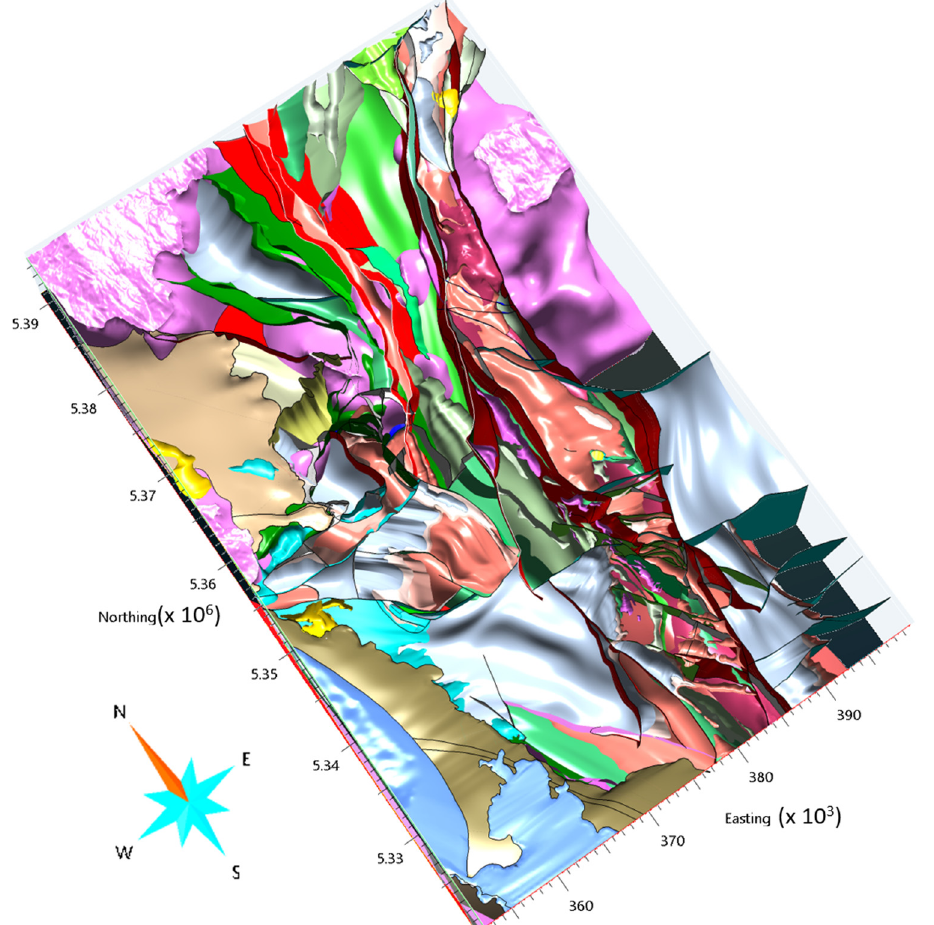
Figure 11. Three-dimensional schematic illustrating the complexity of the Rosebery–Lyell 3D geological model, Tasmania’s most important mineral province. Lithological surfaces are represented by multicolored surfaces, granites (pink surfaces) and fault network architecture (red and blue surfaces). Macquarie Harbor (blue surface) shown in southwest corner of the model.